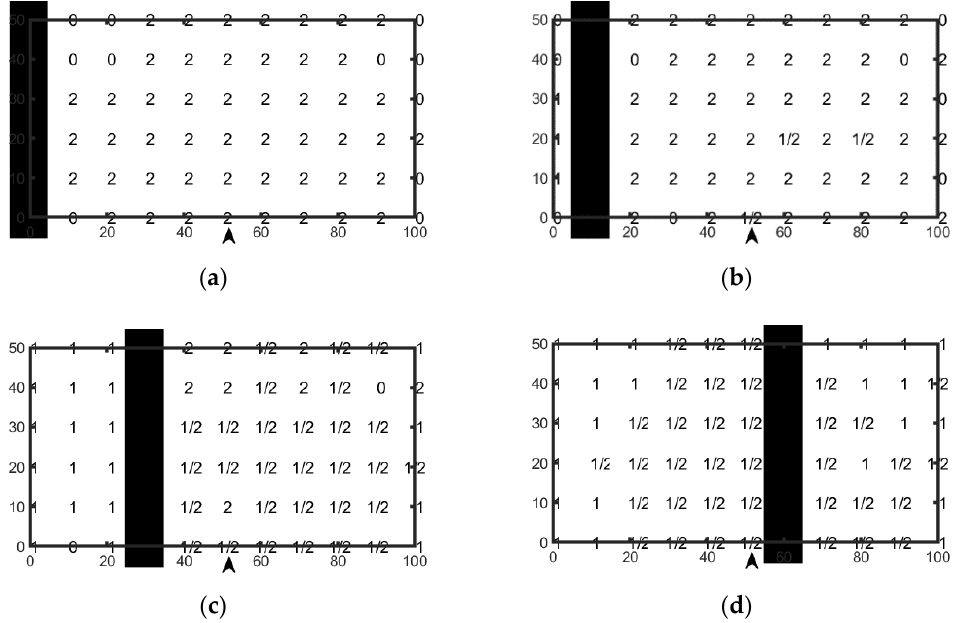
Figure 7. Results showing the tag detection area as a function of the position of the two tags. In particular, tag #1 is fixed on the black cell of each row, chosen as the reference position, while tag #2 is moved to all of the other positions of the same row. The position of the reader is marked by the arrow. In (a)-(d) cases for different positions of tag#1 are presented.